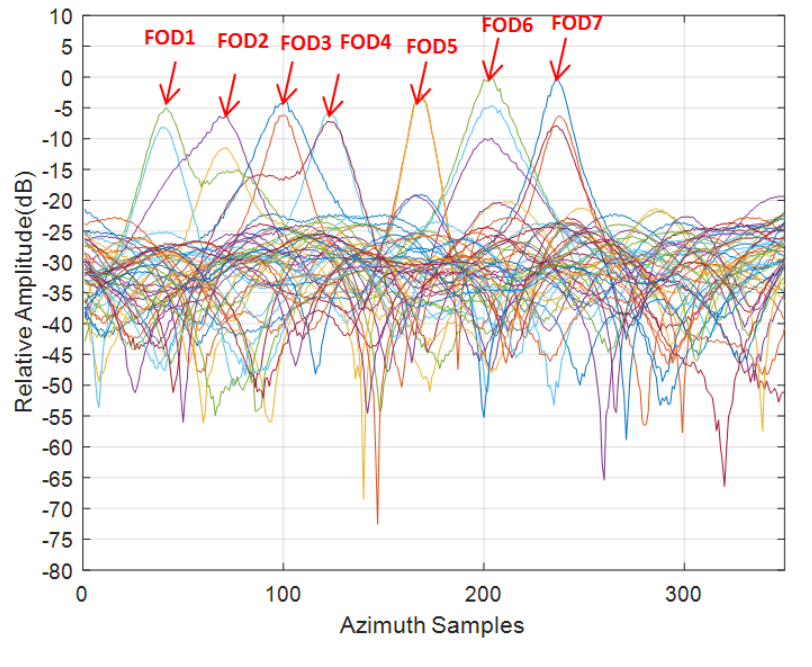
Figure 15. Results after azimuth IAA processing, Scene